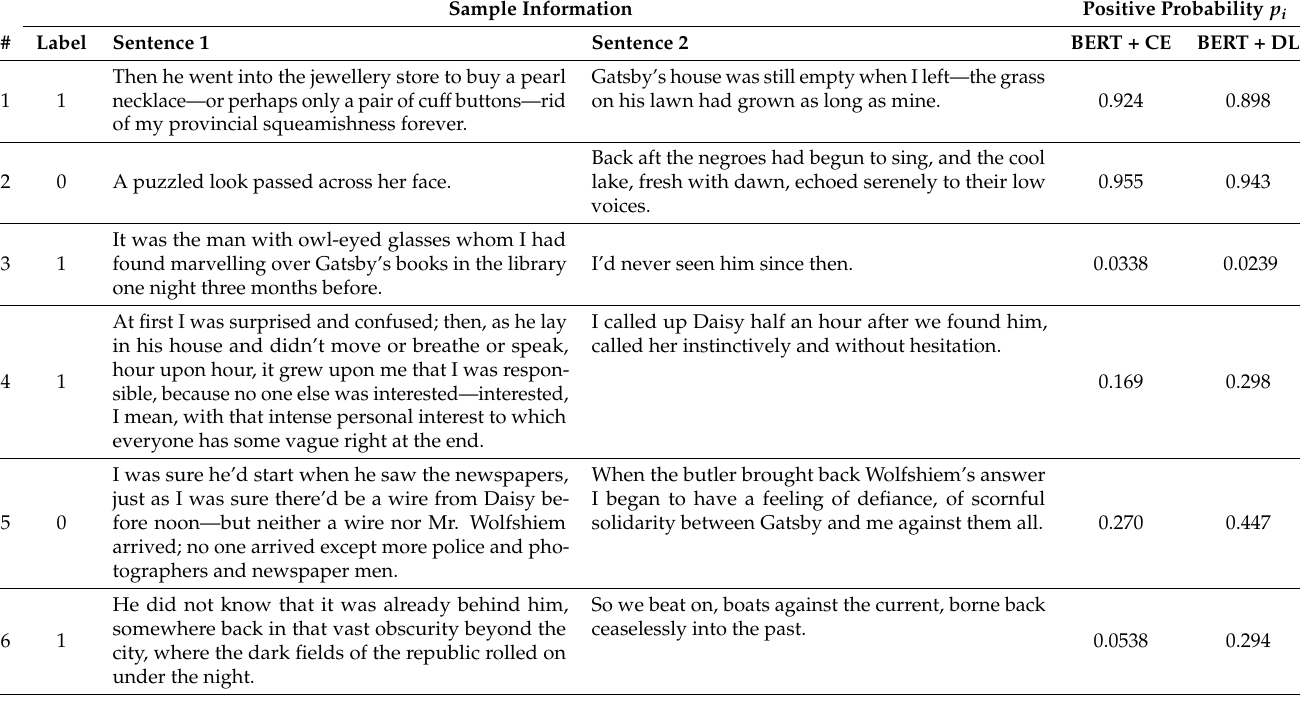
Table 5. Examples of samples in the Fitzgerald dataset, and positive probability of BERT + CE and BERT + DL for these samples. If the positive probability was higher than the threshold, the sample was recognized as a paragraph